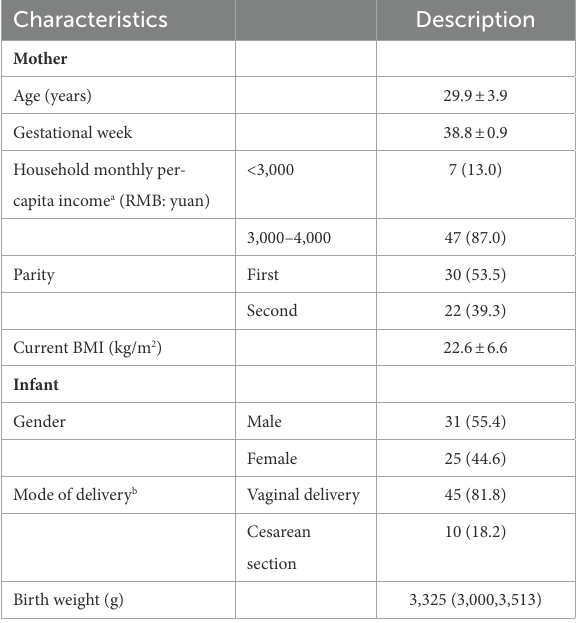
TABLE 1 Basic characteristics of the 56 pairs of mother and infant.